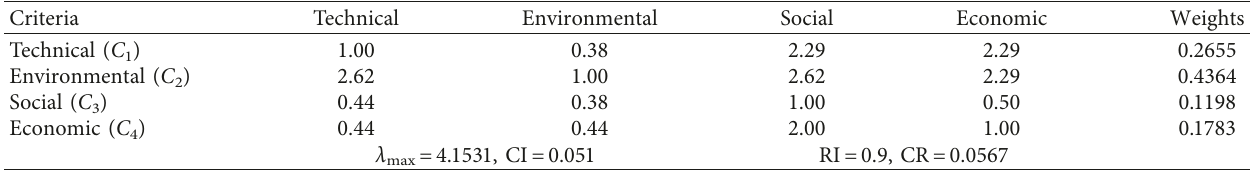
Table 3: Pairwise comparison of sustainability criteria for selection of concrete supplementary material.